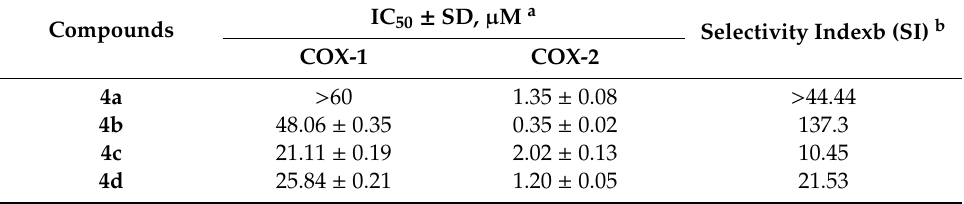
Table 3. COX-1 / COX-2 inhibition of the compounds 4a – 4z and Celecoxib. COX: cyclooxygenase.